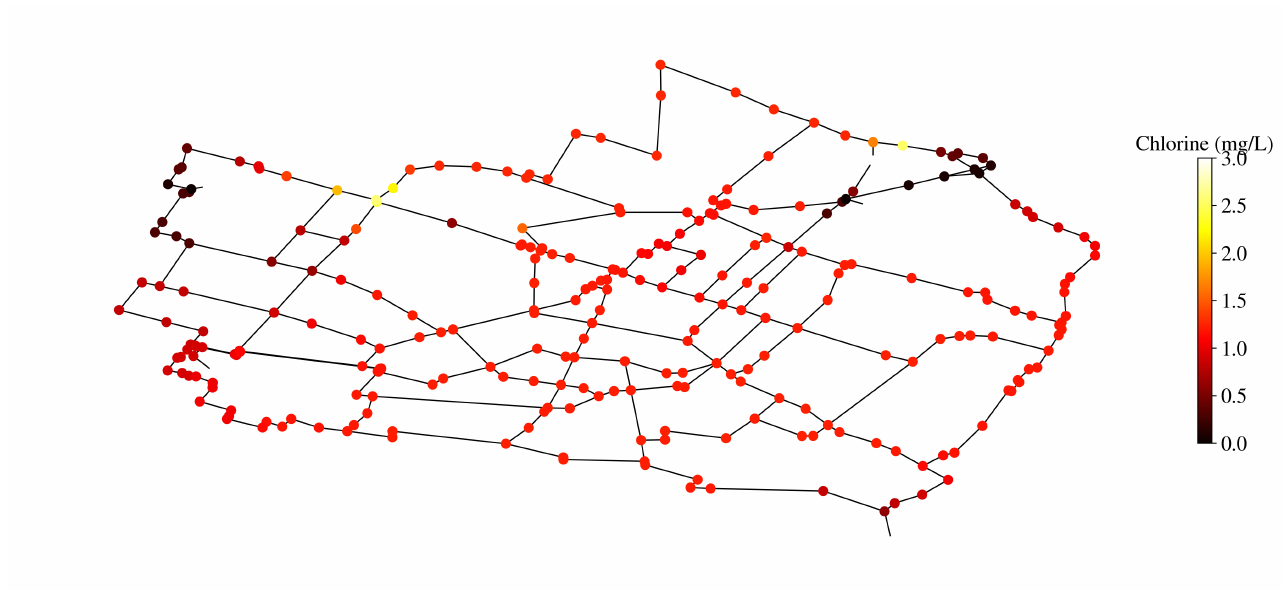
Figure 7. Maximum difference in chlorine